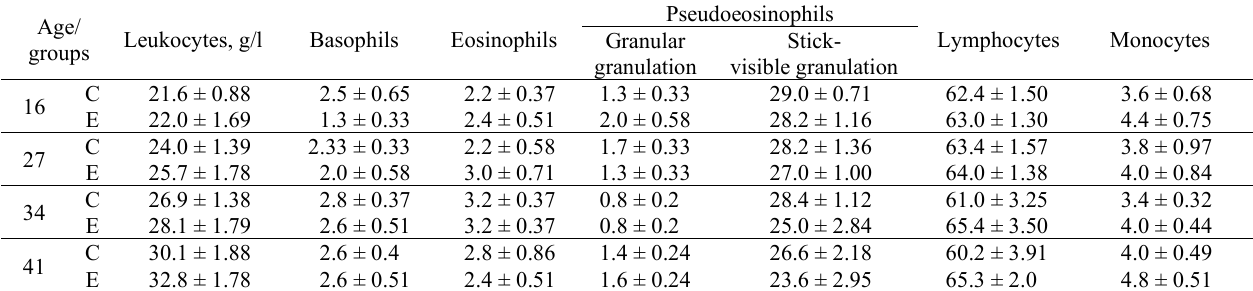
Blood leukogram of broiler chickens, % (М ± m; n = 5) Age/ Leukocytes, g/l Basophils groups